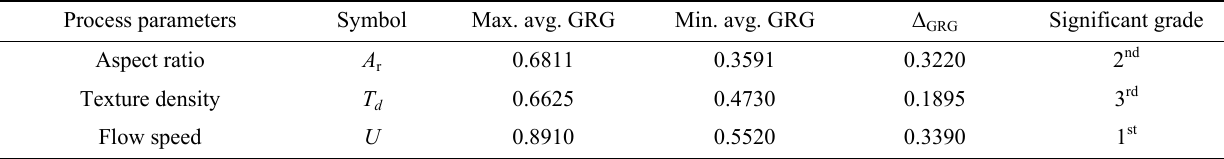
Table 11 The most significant process parameter of curved bottom